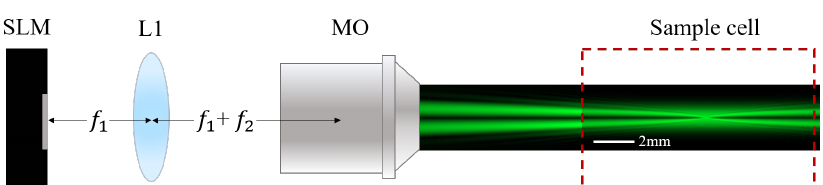
Figure 3. Sketch of the 4 f telescope after the SLM (out of scale), including the simulated linear propagation of the SV past the microscope objective (in scale). The location of the sample cell is framed by a dashed box; in the image plane the dark core appears to vanish.